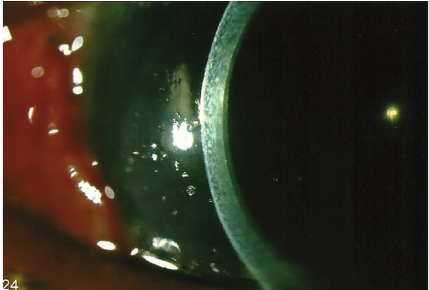
Figure 2: Cross-section showing the absence of EK button on post- operative day 2.